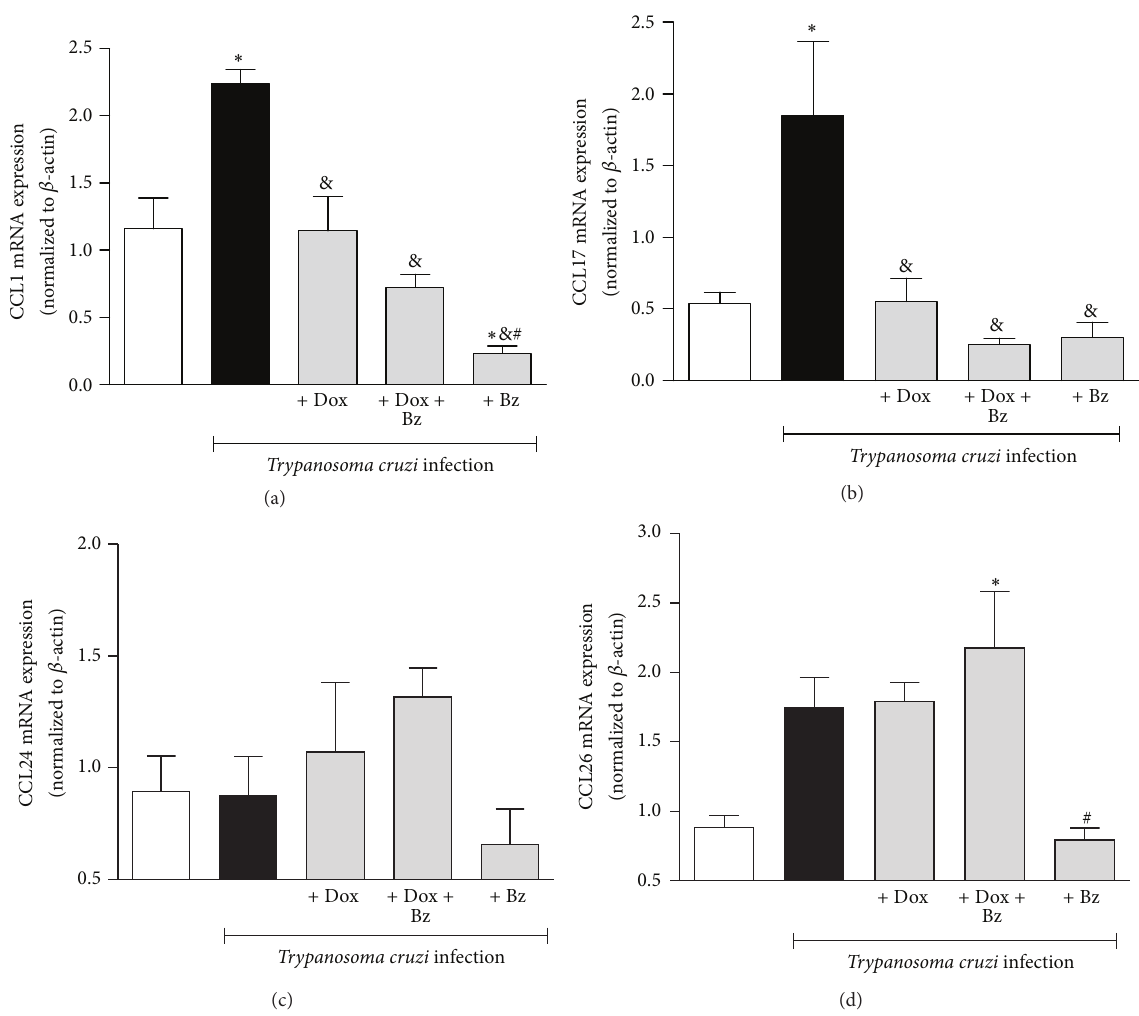
Figure 2: Expression of Th2-like chemokines in the cardiac tissue Trypanosoma cruzi -infected dogs. Th2-like chemokines CCL1, CCL17, CCL24, and CCL26 mRNA expression evaluated in left ventricle tissues. Data are representative of the groups ( 𝑛 = 5 animals) in which the expression of chemokines was normalized to the constitutive beta-actin. ∗ means difference ( 𝑝 < 0.05 ) in relation to the noninfected group; & means difference ( 𝑝 < 0.05 ) in relation to the infected group without treatment; # means difference ( 𝑝 < 0.05 ) in relation to the Dox and Dox +